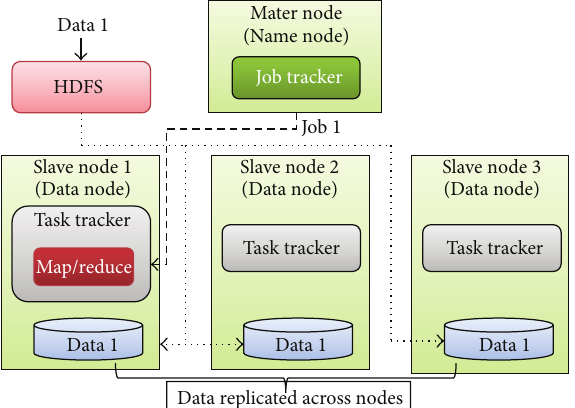
Figure 2: The architecture of a Hadoop cluster.